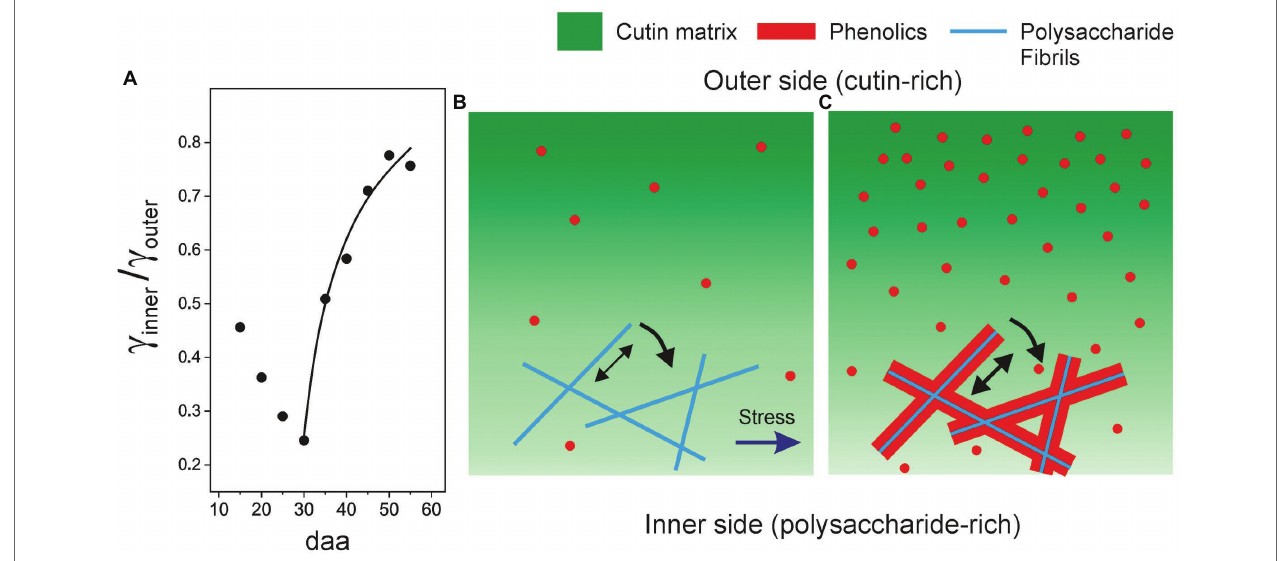
FIGURE 10 | (A) Evolution of the ratio of normalized ( γ ) bands as obtained from the ATR-FTIR spectra from the inner ( γ inner ) and outer ( γ outer ) sides of tomato Cascada cuticles. Structural model showing the fractions (cutin, polysaccharides, and phenolics) distributions in: (B) young and (C) ripe